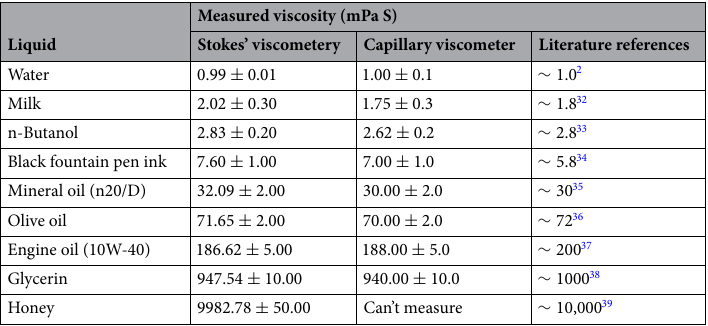
Table 1. Comparison of viscosity of various samples measured with present method and against capillary viscometer and the values reported in